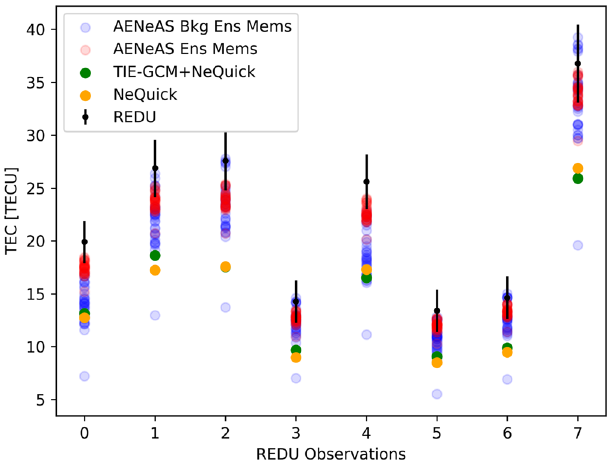
Fig. 7. Observed TEC from REDU and the same TEC values modelled by AENeAS, TIE-GCM+ and NeQuick at 1230, 5 June 2017. The x -axis numbering is the receiver channel number and the ordering is arbitrary.